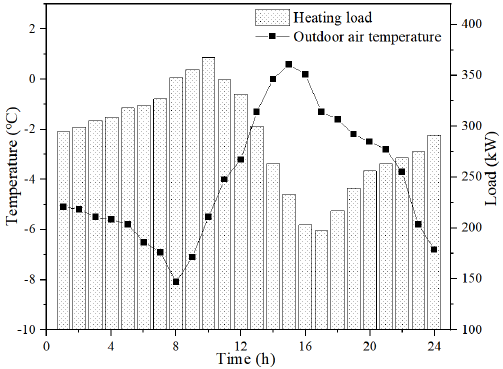
Figure 8. Heating load on typical day.